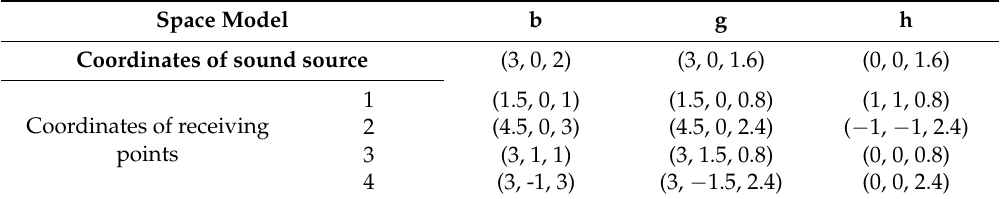
Table 6. The positions of sound source and receiving points in closed-space models.